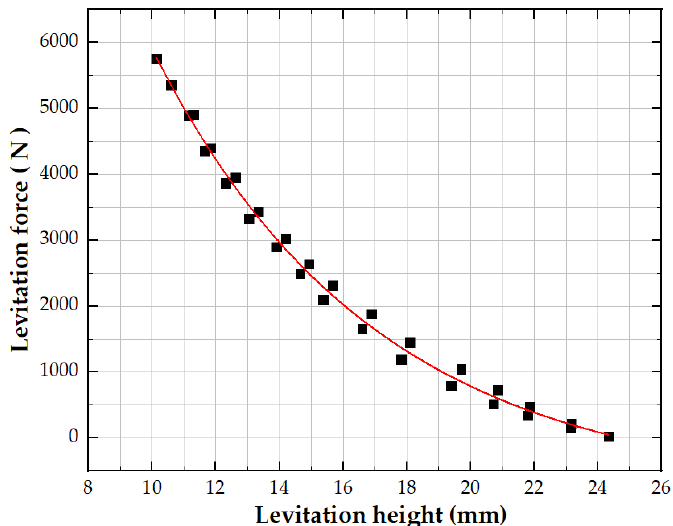
Figure 5. The relationship between levitation force and levitation height of single maglev Dewar used in the test vehicle.